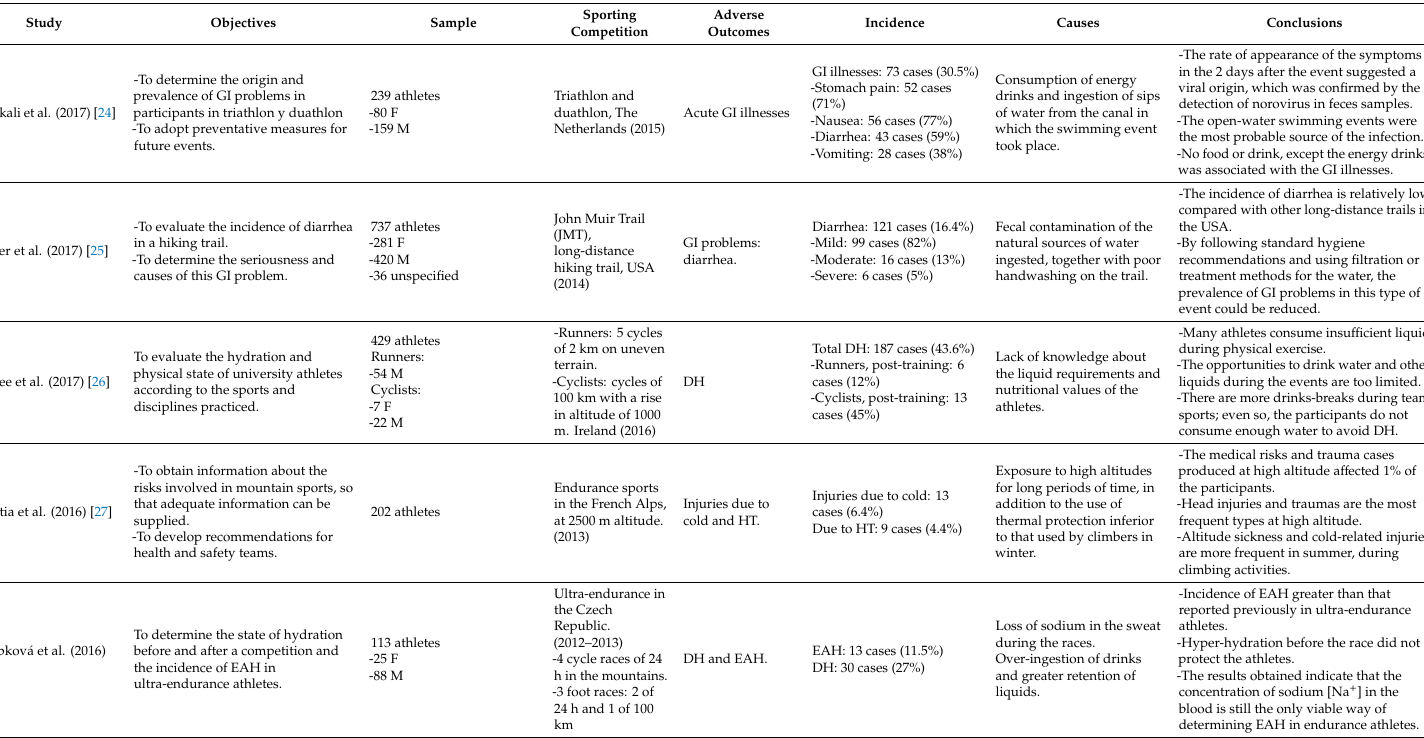
Table 1. Nutrition-related adverse outcomes in endurance and ultra-endurance competitions and sports, in cohort studies. Study Objectives Sample Incidence Causes